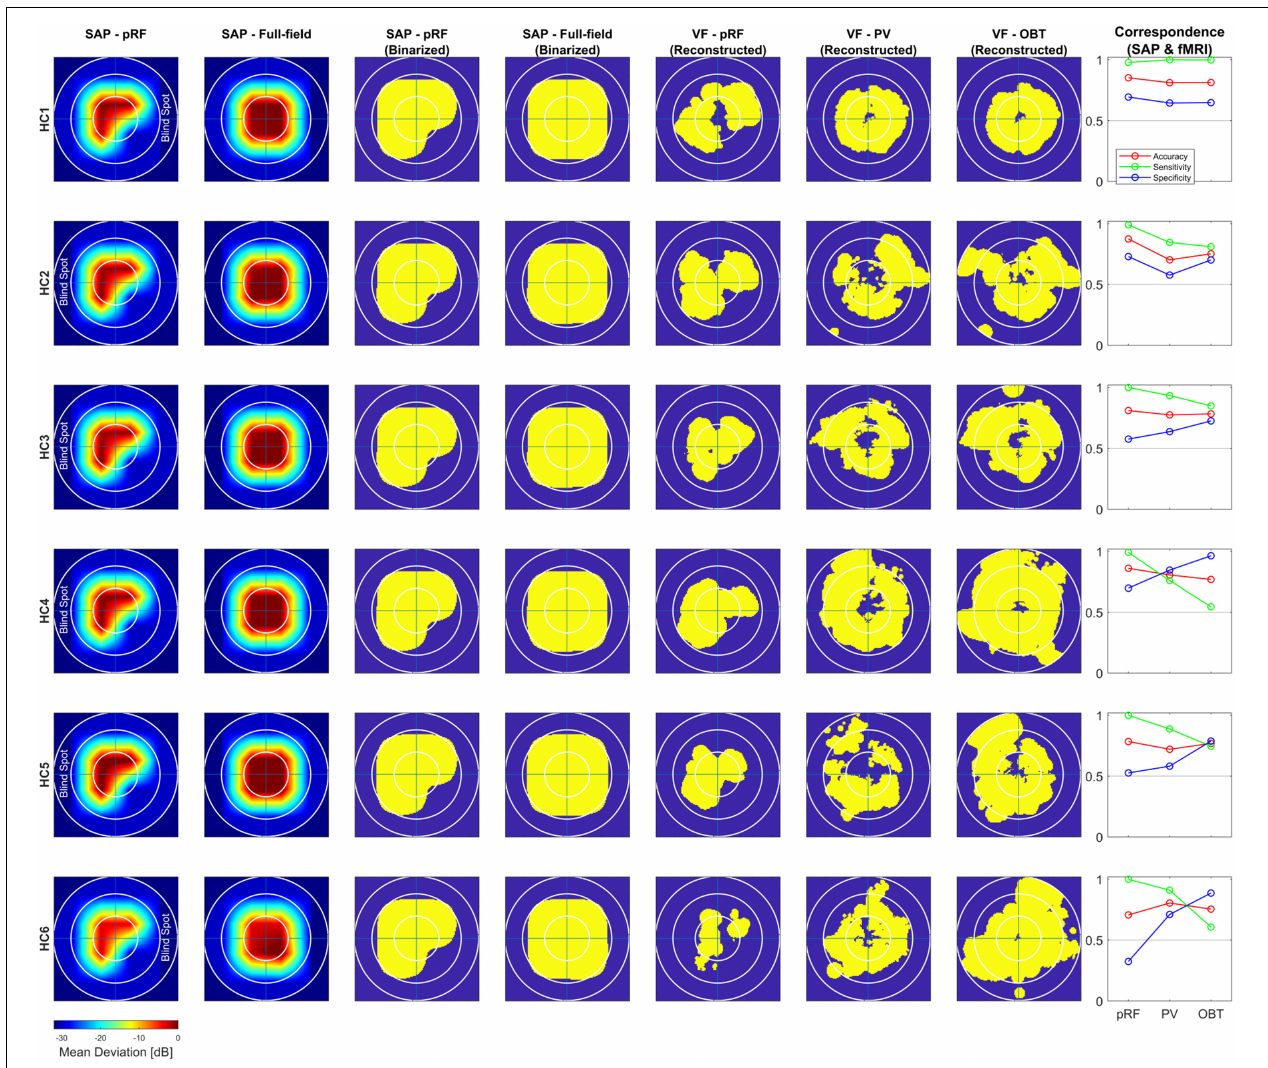
FIGURE 4 | Comparison of subjective (SAP) and objective (fMRI) VF-reconstruction (V1–V3-pooled) in controls. Each row represents one participant, the description for the columnar subplots are as follows: Columns SAP-pRF and SAP-Full-field: Upsampled and interpolated SAP VFs for the central 14 ◦ (radius) for comparison with pRF-based and atlas-based coverage maps, respectively. The reason for two different SAP-VFs is, in addition to a peripheral artificial scotoma ( > 7 ◦ ), the pRF-mapping stimulus had a quadrantopic scotoma stimulation as well. SAP-pRF and Full-field (Binarized): Binarization procedure for the two SAP-based VFs followed same convention as in Figure 3 . Columns VF – pRF, PV, and OBT: Binarized pRF-based and atlas-based (PV and OBT) coverage maps, thresholded at a pRF coverage of 0.7; Correspondence (SAP and fMRI): conventions same as Figure 3